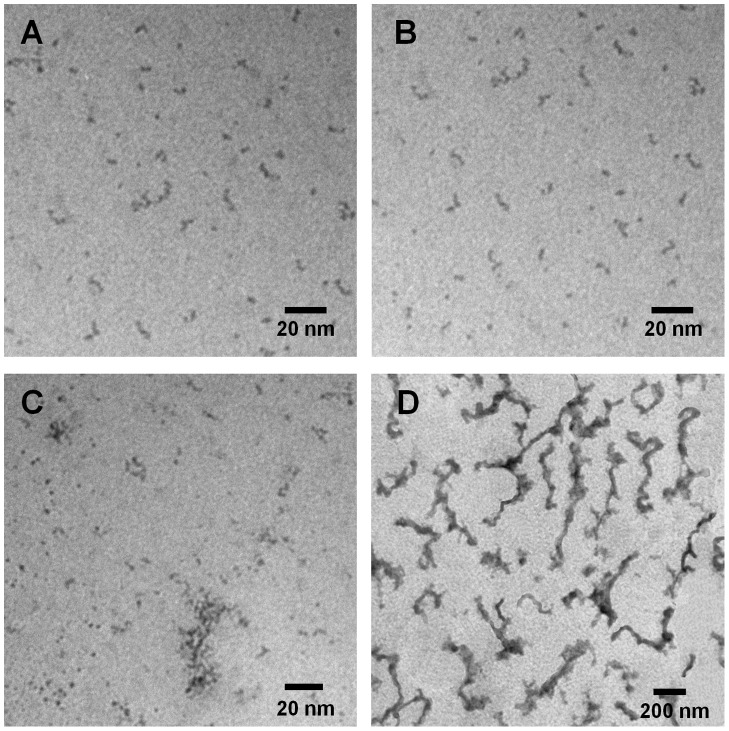
Effect of ribosylation on the morphology of the W7FW17F apomyoglobin aggregates.Electron microscopy images of the W7FW14F apomyoglobin in the absence of D-ribose at the beginning (A) and after 5 days of incubation (B), and in the presence of D-ribose at the beginning (C) and after 5 days of incubation (D). Experimental conditions are described in the Materials and Methods section.